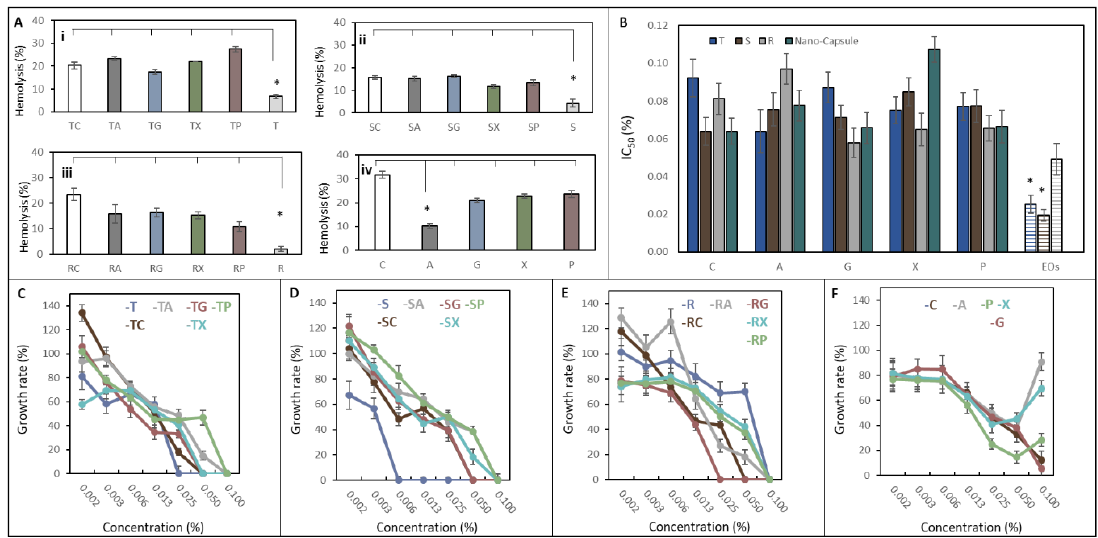
Figure 3. Inhibition activity on eucaryotic model and blood compatibility assessment of Ncaps: ( A ) Hemolytic assay of C-NCaps (concentration of EOs was 0.1% v/v ): ( i ) Thymus vulgaris , ( ii ) Syzygium aromaticum , ( iii ) Rosmarinus officinalis and ( iv ) empty NCaps. As a positive control, 30% H 2 O 2 was used, and the negative control was phosphate buffer saline (PBS). ( B ) Comparison of IC 50 of studied NCaps and EOs ( Thymus vulgaris (T), Syzygium aromaticum (S), Rosmarinus officinalis (R) and empty Ncaps). The growth rate of S. cerevisiae in the presence of EOs Thymus vulgaris NCaps is shown for ( C ) Thymus vulgaris , ( D ) Syzygium aromaticum, ( E ) Rosmarinus officinalis and ( F ) empty NCaps. The growth rate was calculated as a percentage of growth rate from untreated S. cerevisiae . Results are expressed as an average of three measurements n = 3. The asterisks indicate a difference in the significance level p < 0.05.